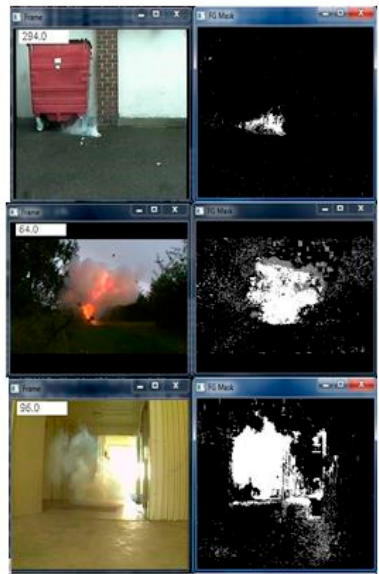
Figure 6. Some results of the background subtraction using the Gaussian mixture model (GMM).